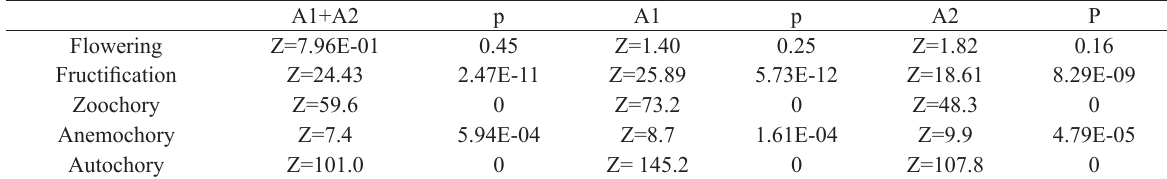
Circular analysis of the reproductive phenology of number of trees and bush species on an escarpment slope in the Serra de Maracaju, Mato Grosso do Sul, Brazil. (A1=